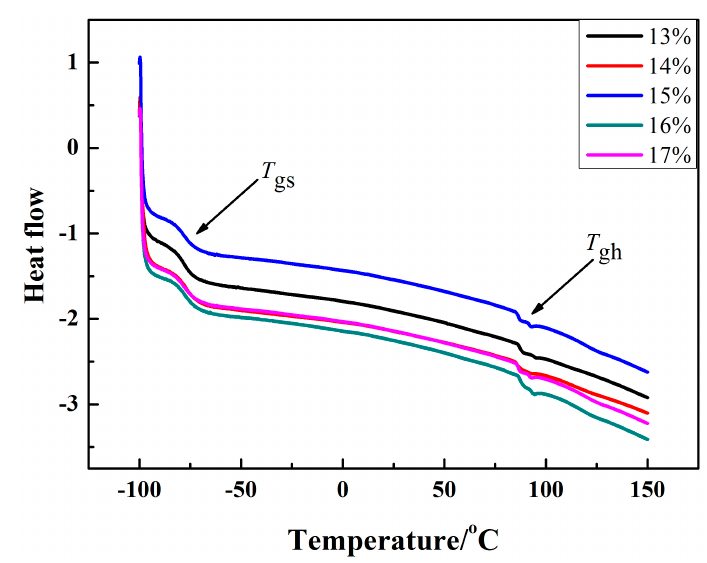
Figure 3. DSC curves of IWPU films.